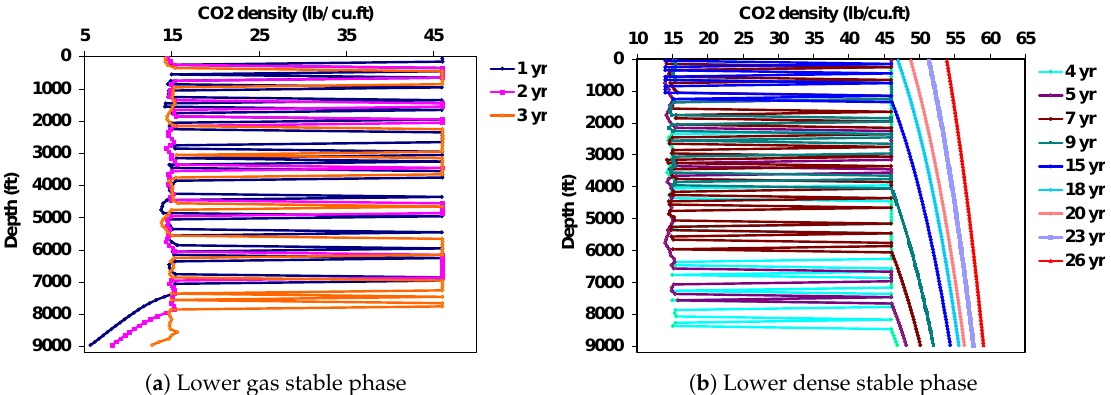
Figure 14. CO 2 density in the wellbore vs. depth at different times; the CO 2 phase-state changes with time as the reservoir pressure builds up. The plot on the left ( a ) shows one unstable two-phase region and one stable state region. The plot on the right ( b ) shows one unstable two-phase state and one stable state region until 18 years of injection. As the pressure increases above the bubble-point pressure everywhere in the wellbore (after 18 years), CO 2 forms one stable single-phase phase region throughout the whole